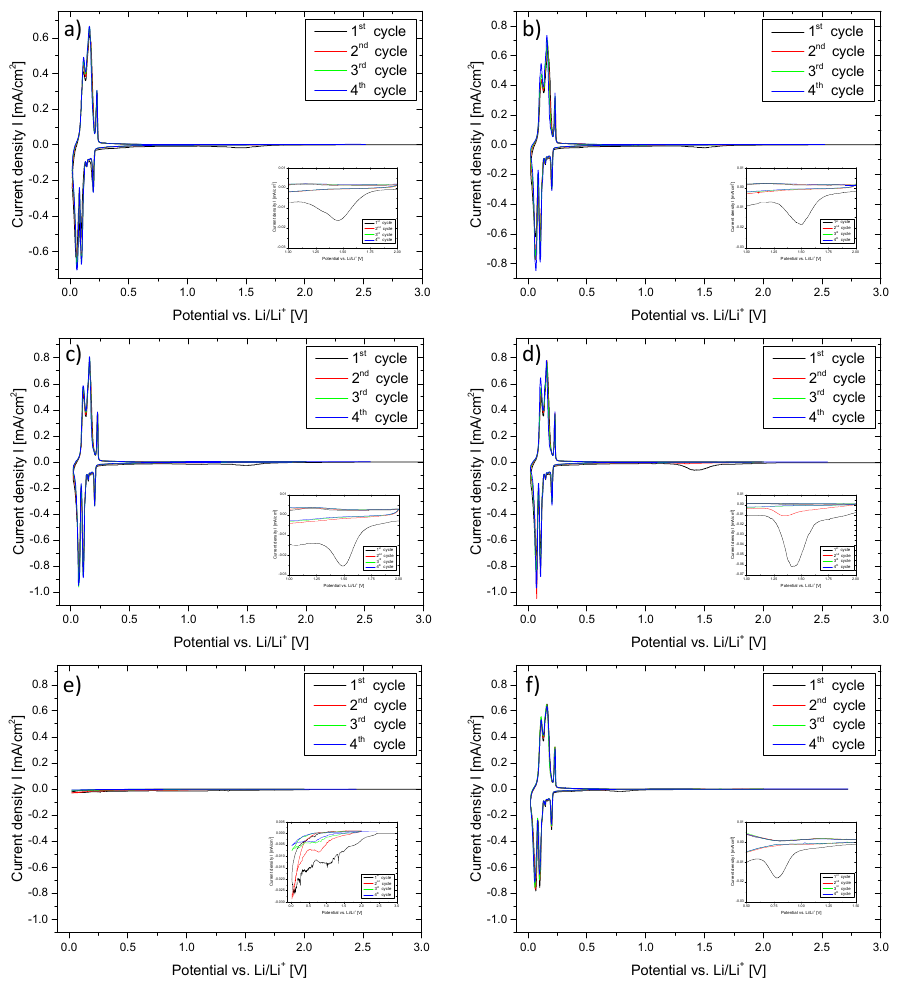
Figure 3. Cyclic voltammograms of T44 graphite / lithium cells containing 1M LiPF 6 in ( a ) BN:FEC (1:1), ( b ) BN:FEC (6:4), ( c ) BN:FEC (7:3), ( d ) BN:FEC (8:2), ( e ) BN:FEC (9:1) and ( f ) EC:DMC (1:1) as electrolyte formulation, in the potential range between 0.02–2.00 V vs. Li / Li + , at scan rate of 20 µ V s − 1 ; insert shows the magnification of the reductive decomposition peak of fluoroethylene carbonate (FEC) at 1.5 V vs. Li / Li +